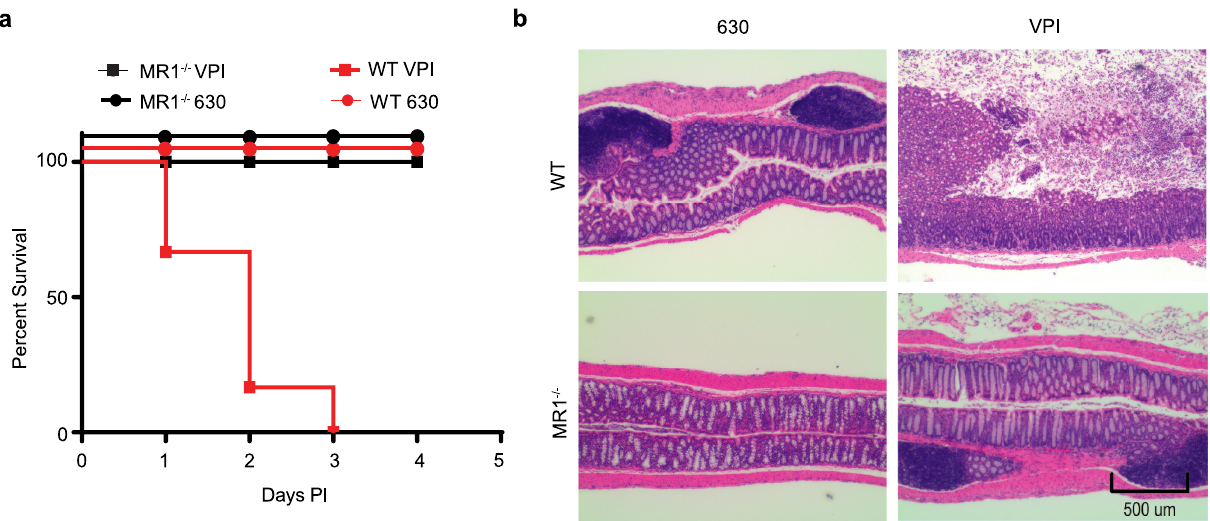
Fig 5. MR1 -/- mice are resistant to highly virulent strains of Cd . (A) WT and MR1 -/- mice were inoculated with either 1x10 3 Cd 630 or Cd VPI spores and assessed for disease daily. (B) H&E staining of colons harvested at time of euthanasia or at the study endpoint (4 days PI). n = 12 mice per group.